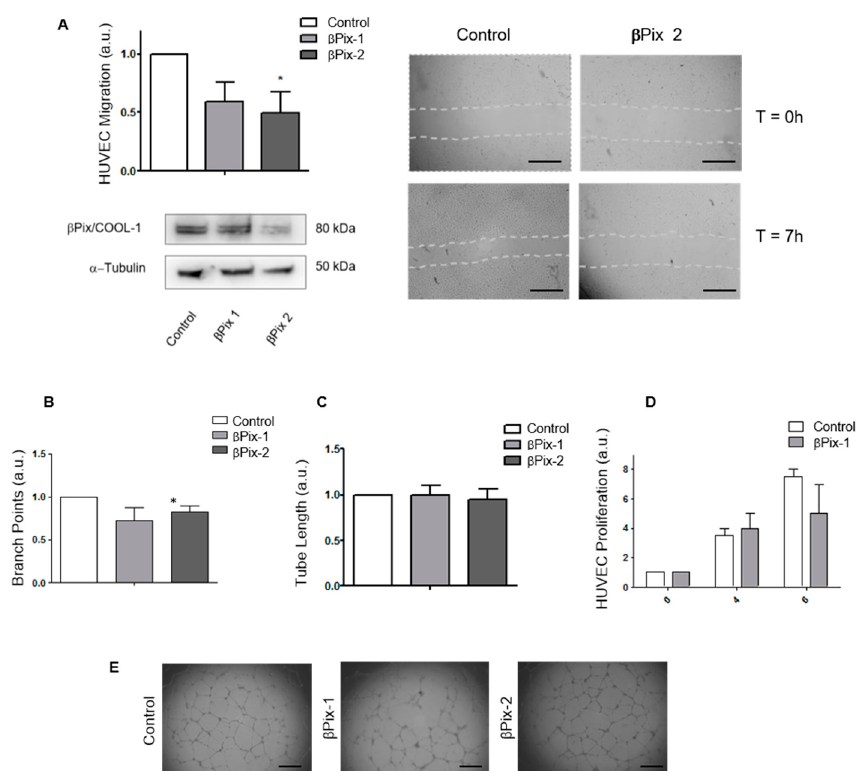
Figure 4. β PIX/COOL-1 mediates endothelial cell migration but does not play a role in endothelial cell tube formation or proliferation. ( A ) Wound closure was more complete in the control cells